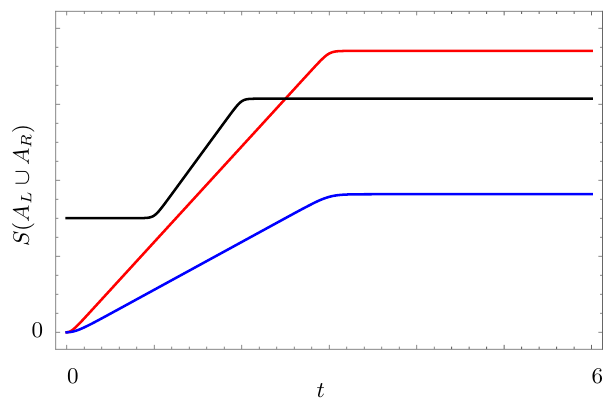
Figure 4 . The exact behaviour of the von Neumann entropy for free fermion BCFT for semi- infinite intervals with a 1 = a 2 = 3 , β = 1 (blue), a 1 = a 2 = 3 , β = 0 . 5 (red) and a 1 = 1 , a 2 = 3 , β = 0 . 4 (black).